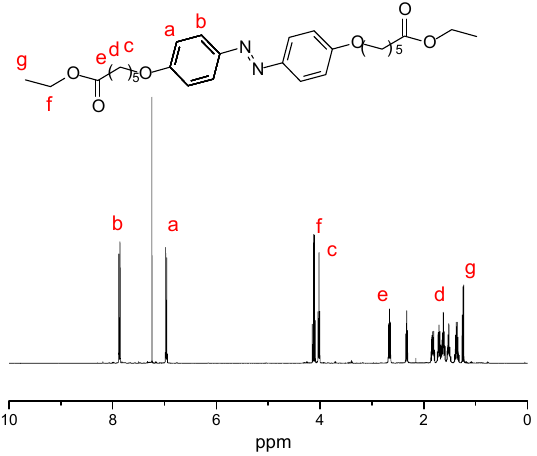
Figure 1. 1 H NMR spectrum of compound 1 in methanol-d4.